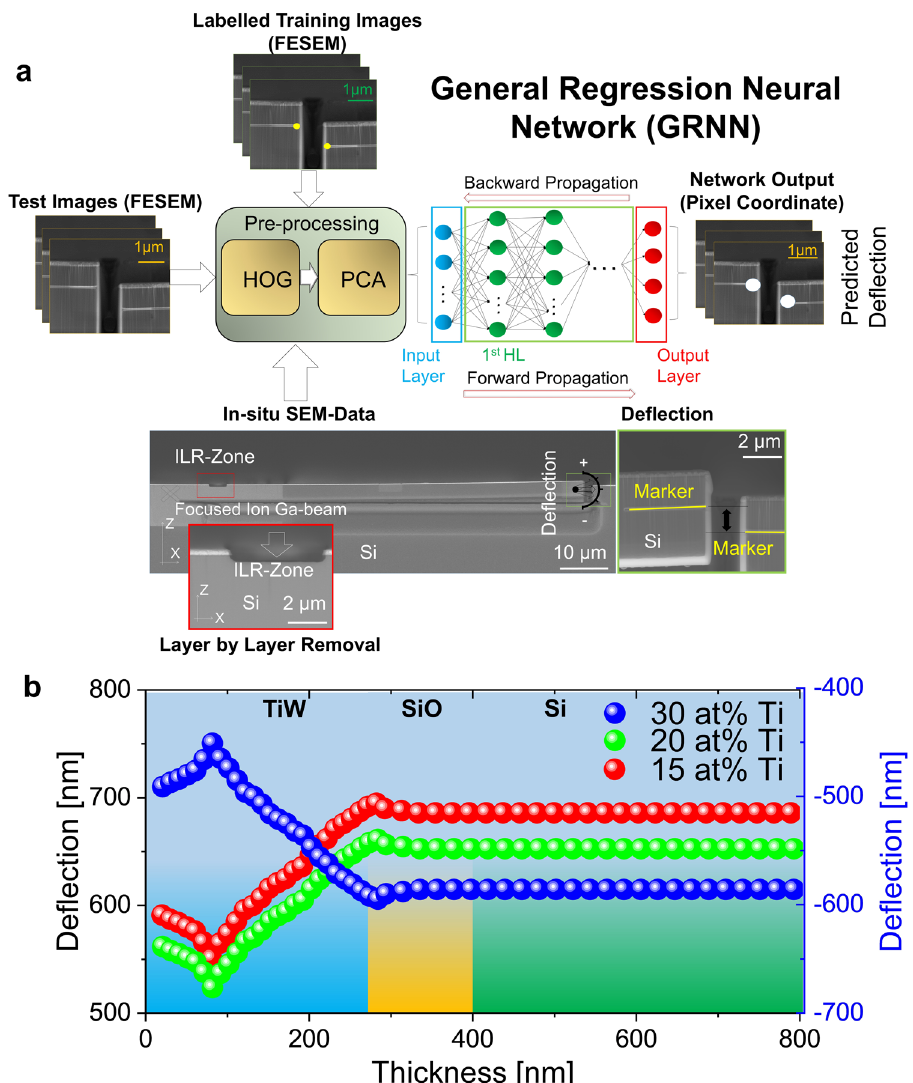
Fig. 2 ML-assisted work fl ow to extract the de fl ection from the SEM-FIB image data for different removal steps. a The schematic shows the ML-assisted work fl ow used to extract the de fl ection for different removal steps from the collected image data. The work fl ow includes: (1) the post-processing of the in- operando SEM-FIB image data utilizing histogram of gradient (HOG) and principal component analysis (PCA), (2) the training of the general regression neural network (GRNN) with the manually labelled image data, (3) the input of the GRNN using the post-processed image SEM-FIB data, and (4) the output generating the de fl ection. Two imprinted markers (highlighted with white points), one localized on the cantilever (moving part) and one located on the opposite site of the cantilever (non-moving part) are used to determine the de fl ection of the cantilever for different cutting depths. b Depicted de fl ection from the GRNN-model for 15 at% (red), 20 at% (green) and 30 at% (blue) Ti over the layer thickness with a step-size of 15 nm. Background indicates the different layers in the thin fi lm stack: W 1-x Ti x (blue), SiO (orange), Si (green). The de fl ection pro fi le changes signi fi cantly within the different W 1-x Ti x layer con fi gurations. A constant de fl ection is shown for the SiO and Si layers. The latter makes sense since this layer should be